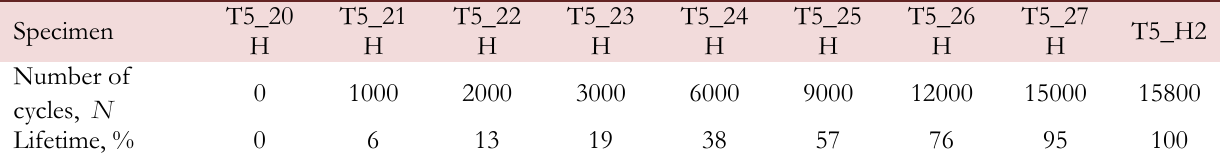
Table 2: Nomenclature of T5-H2 specimens and fatigue loading program.